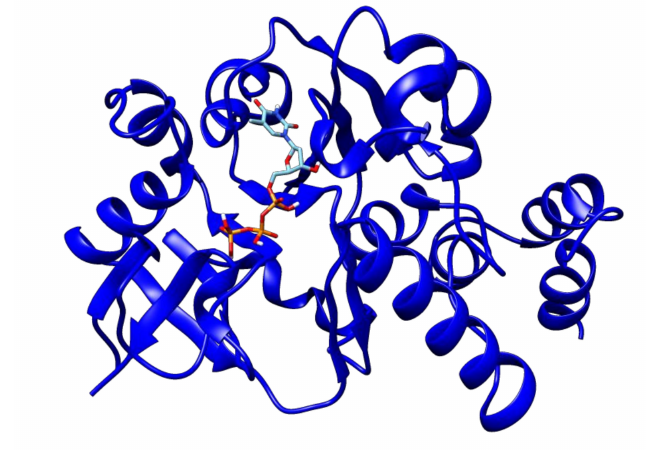
Figure 6. The docked complex of thymidine-5 (cid:48) -triphosphate and glucose-1- phosphate